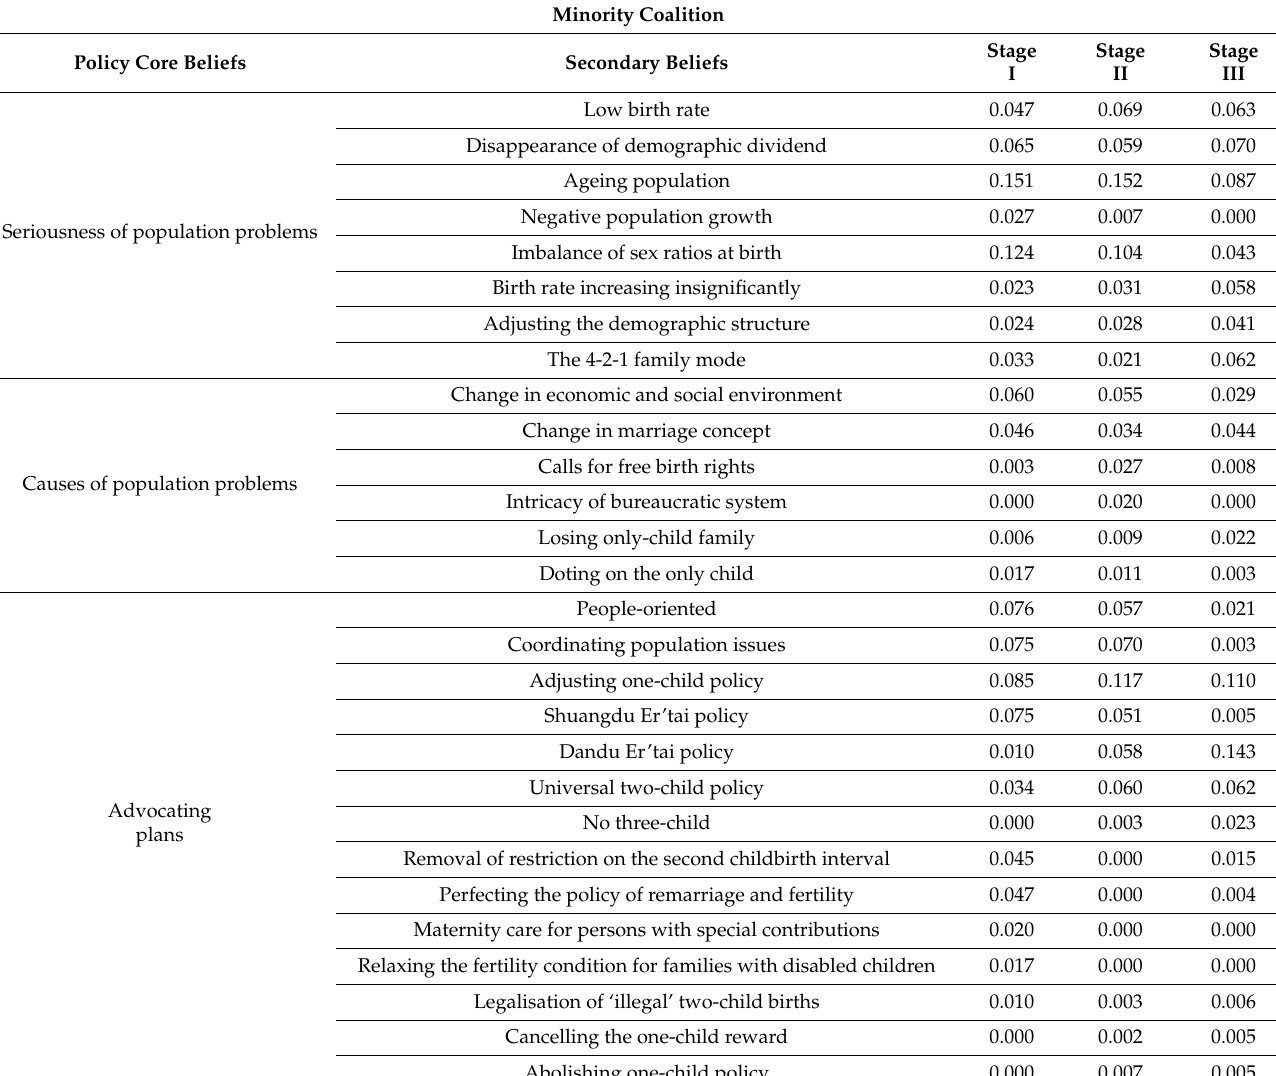
Table 8. Degree centrality analysis of discourse concept from the minority